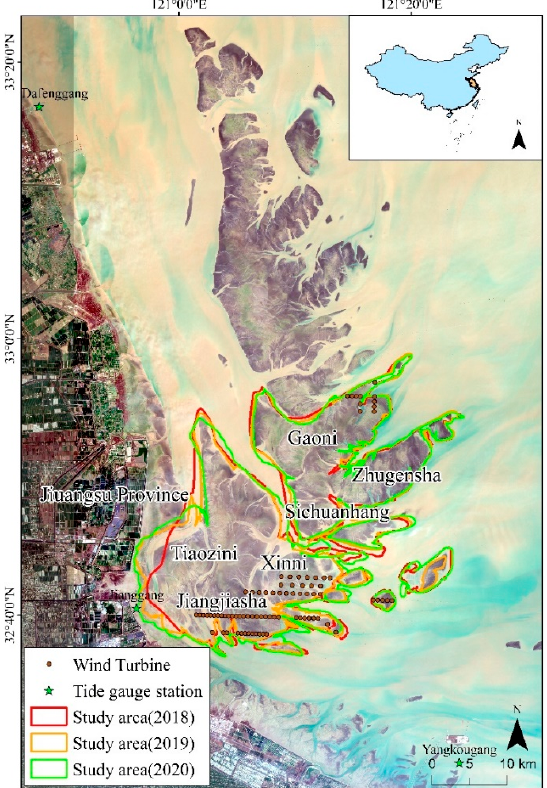
Figure 1. Location map of the study area showing the distribution of tidal gauge stations and wind turbines. (Differently coloured boxes indicate the extent of the constructed DEM for the corresponding year; asterisks indicate the locations of tidal gauge stations; dots indicate wind turbine